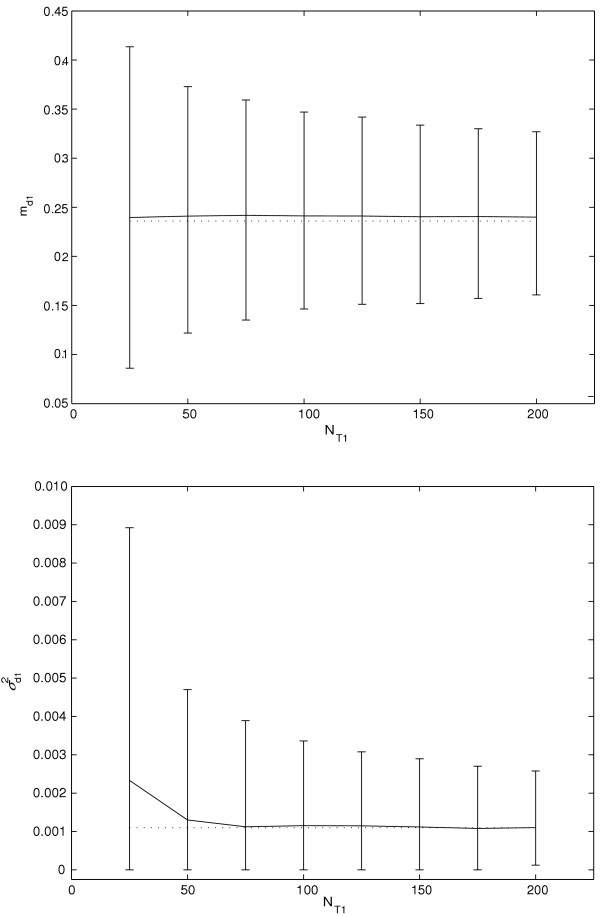
Unbiased estimates of md1 (top) and σd12 (bottom). The true values of md1 and σd12 (dotted) are compared to the average of 50 conservative point estimates of md1 and σd12 (solid) for the 2-dimensional normal distributions used where Nd = 100. Also displayed are two-sided 95% CIs, based on histograms of the 5000 estimates for different values of the test bag size NT1. The true md1 and σd12 were obtained by testing 10,000 independently designed classifiers using 100,000 new, independently generated, test samples from the two normal distributions used. The estimates of md1 are unbiased and the estimates of σd12 are unbiased for NT1 ≥ 100.